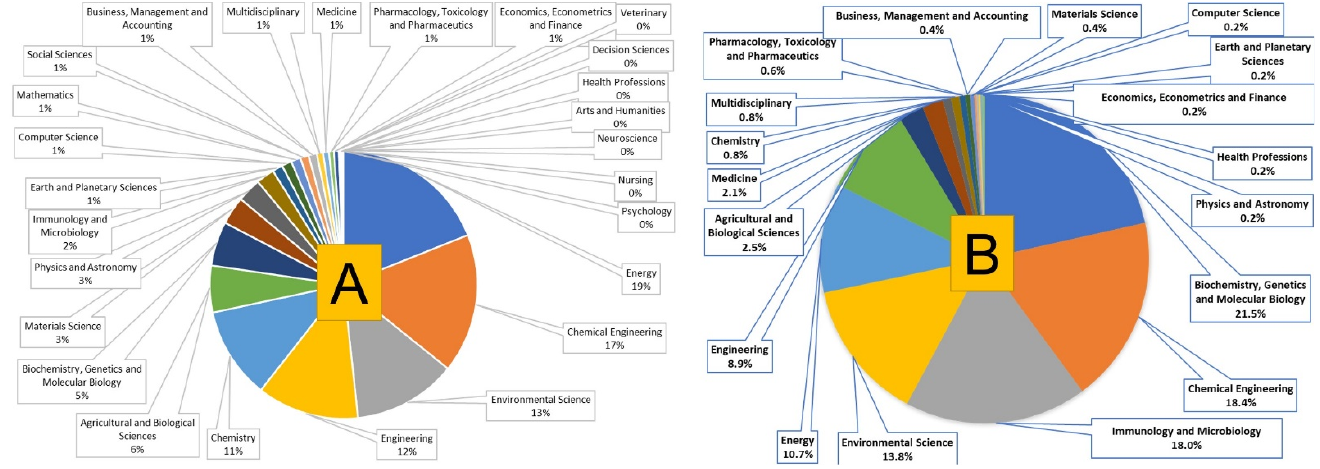
Figure 6. Documents published in different discipline with keywords ( A ) ‘biodiesel’ and ( B ) ‘biodiesel and bioengineering’.